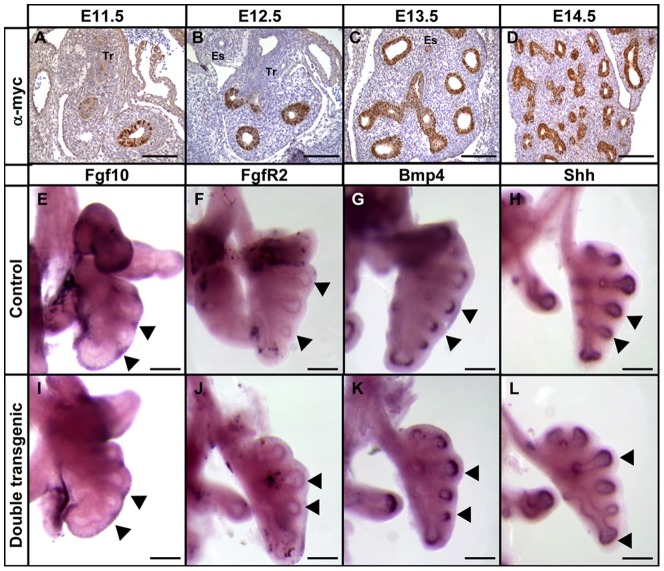
Expression of genes involved in branching morphogenesis.Analysis of the distribution of mycHIF3α early in lung development in double transgenic animals at E11.5 (A), E12.5 (B), E13.5 (C) and E14.5 (D). Whole mount in situ hybridization to detect the expression and localization of Fgf10 (E and I), FgfR2 (F and J), Bmp4 (G and K) and Shh (H and L) in lungs isolated at gestational age E12.5 from control (E–H) and mycHIF3α double transgenic animals (I–L). Tr: Trachea; Es: Esophagus. Scale bars: 200 µm.